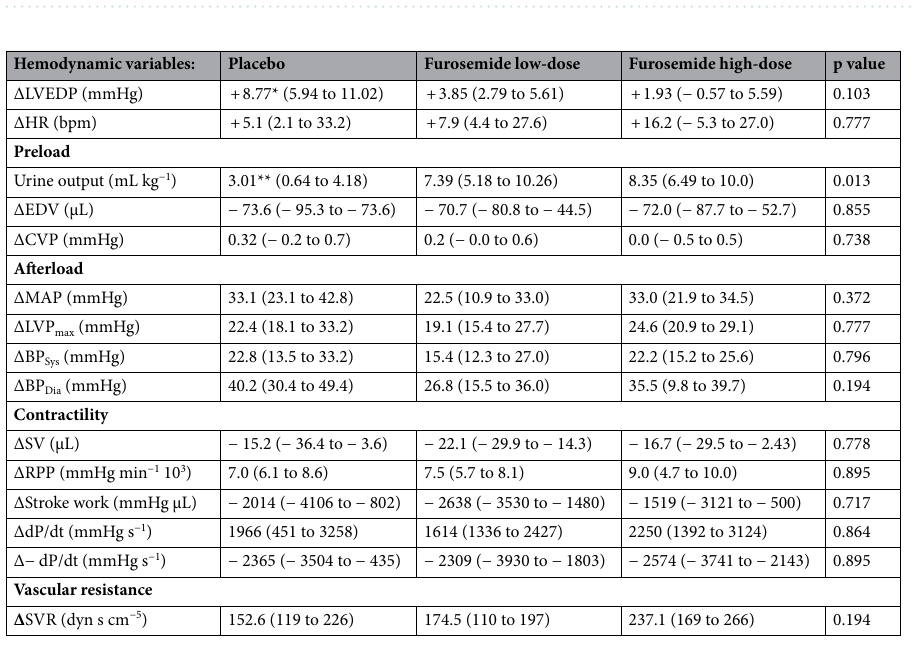
Figure 2. Urine output and P/F-ratios per treatment group. ( A ) There is a dose–effect response to the administration of furosemide and total urine output following randomization. ( B ) P/F-ratio shown between treatment groups.